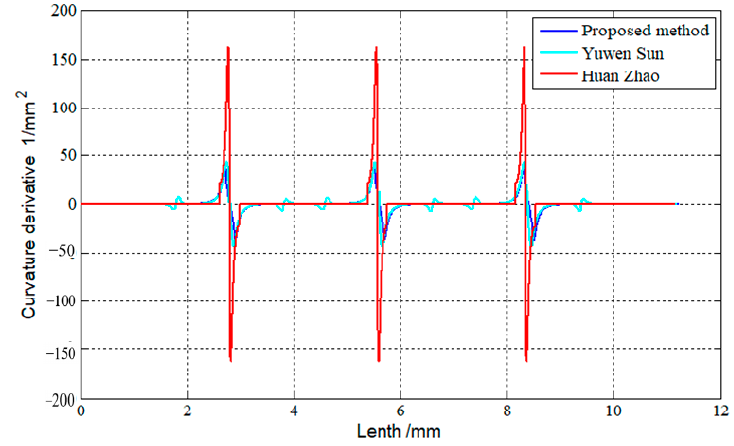
Figure 5. Curvature derivative profiles of 2D tool path.